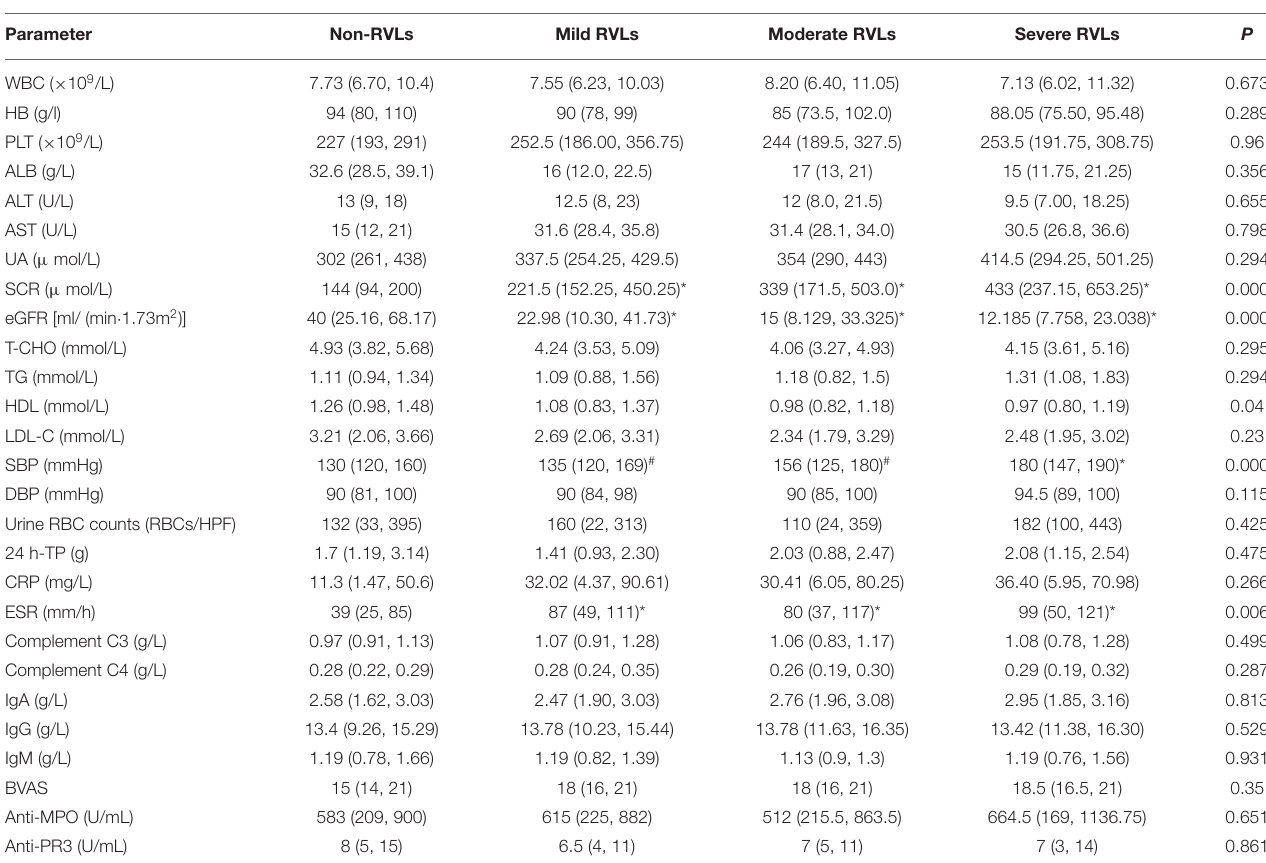
TABLE 2 | Clinical indexes of the non-RVL, mild RVL, moderate RVL, and severe RVL